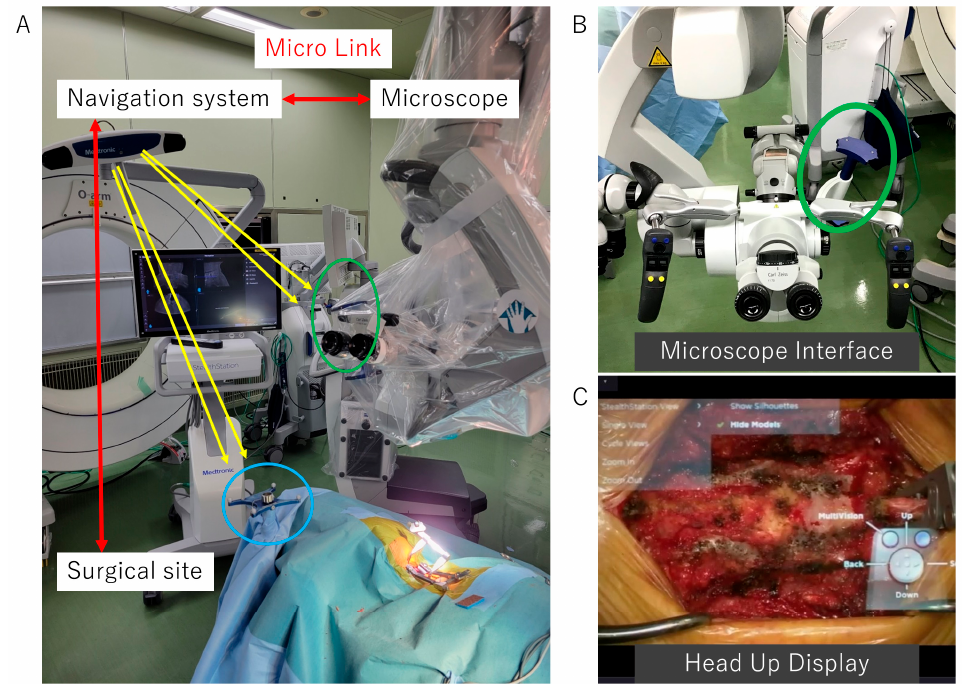
Figure 1. Operating room se tt ing. ( A ) Operating room se tt ing. The navigation camera tracks the microscope interface (green circle) and the reference frame that is a tt ached to the patient (blue cir- cle). ( B ) Microscope interface (green circle) to track its position during surgery. ( C ) AR support